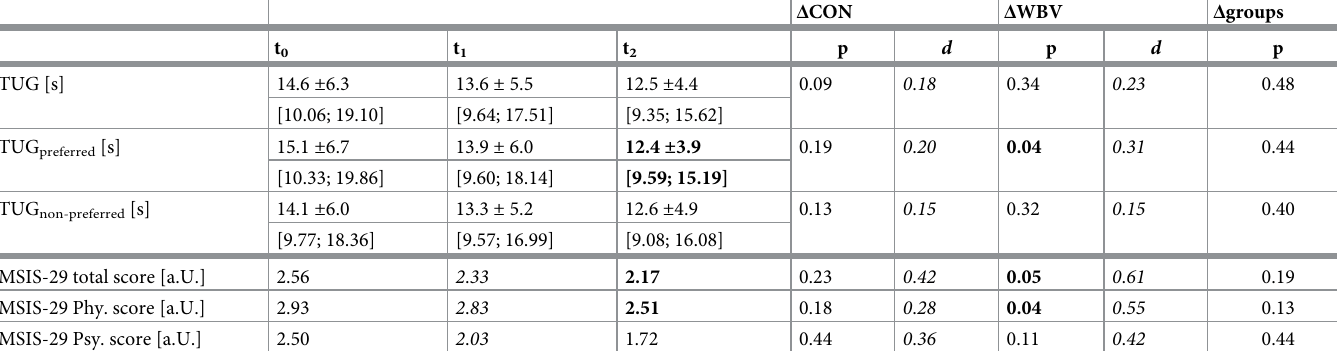
Table 3. Results of functional mobility and impact of MS during everyday life for the Timed “Up & Go” test (top) and for the MSIS-29 questionnaire scores (bottom).